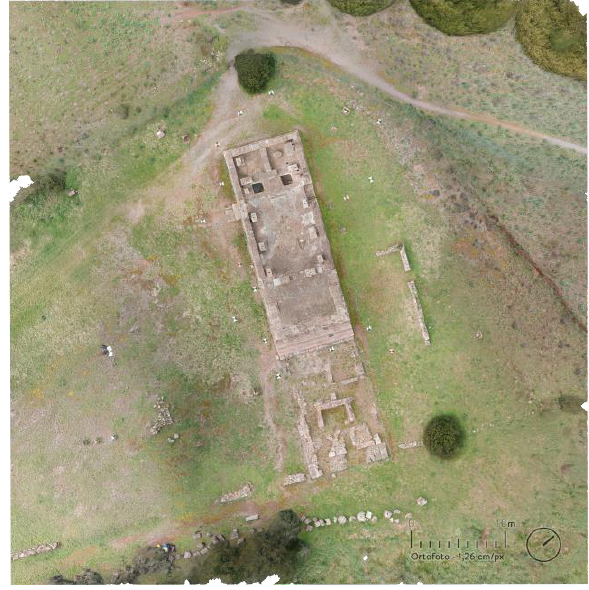
Figure 12. Orthomosaic of the